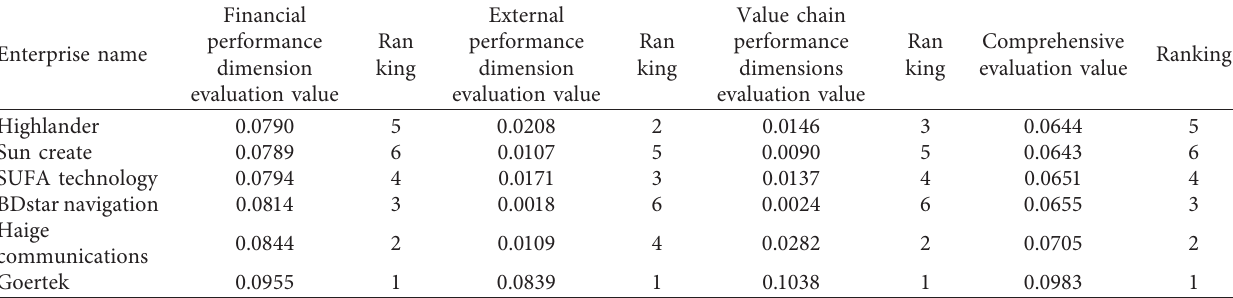
Table 4: Performance evaluation results of intellectual property value